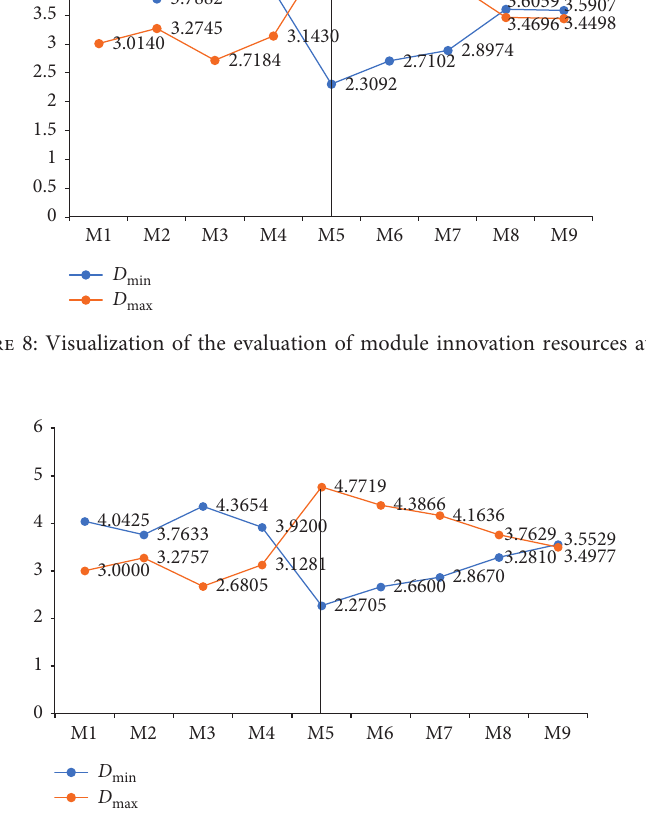
Figure 9: Visualization of the evaluation of module innovation resources at τ �